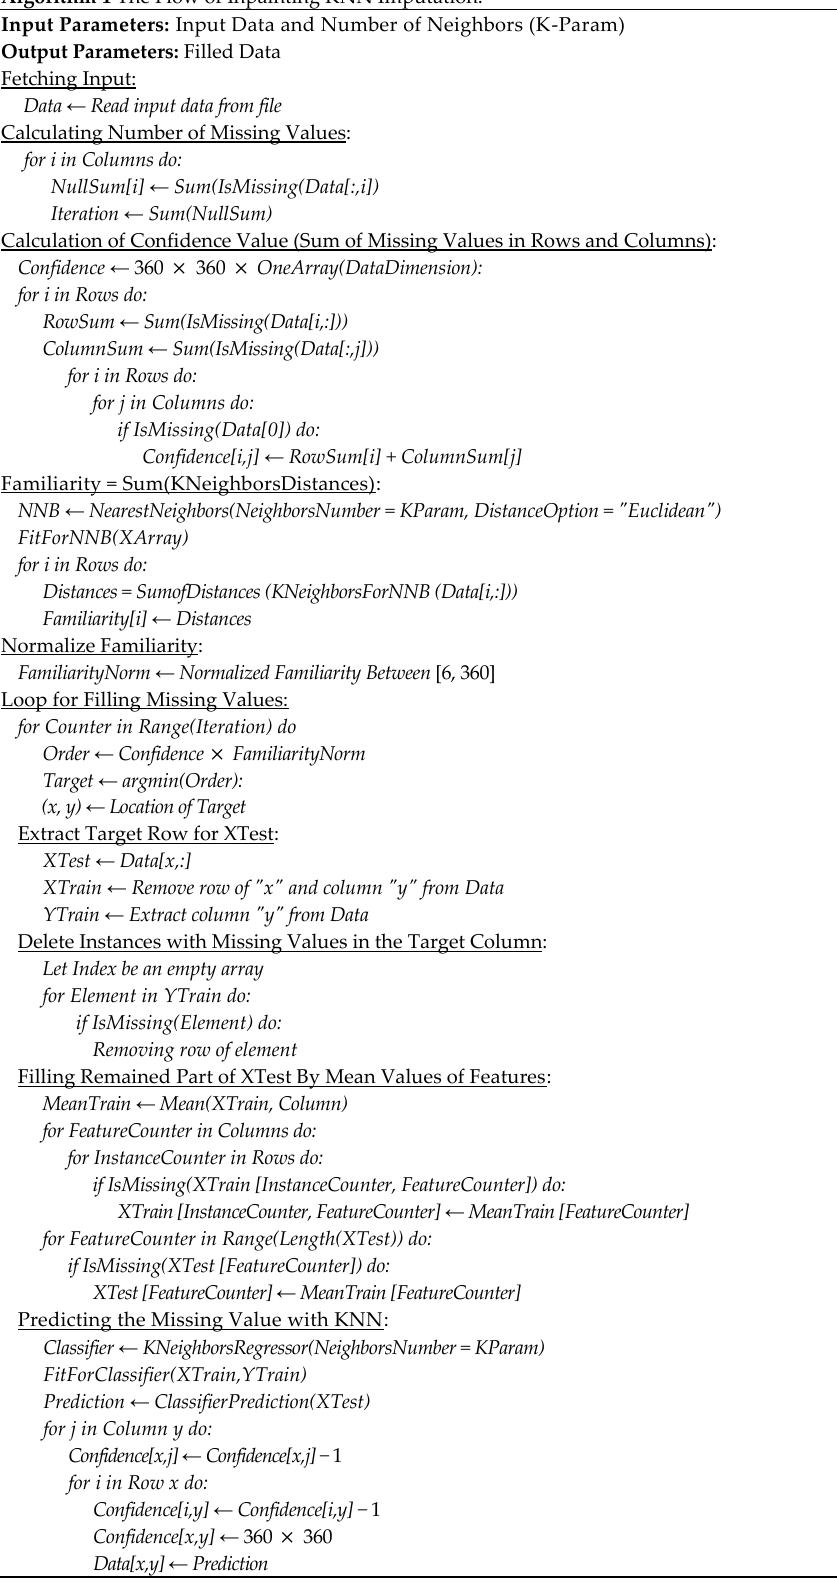
Algorithm 1 The Flow of Inpainting KNN